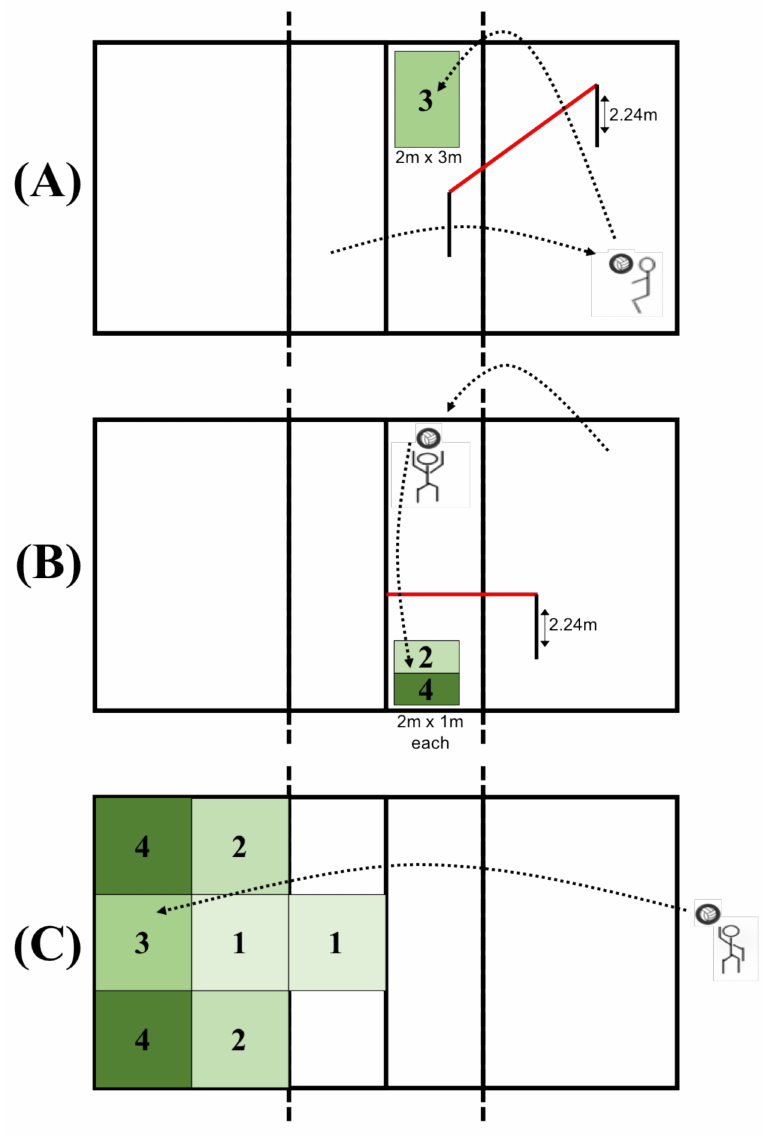
Figure 1. Test designs for the three volleyball techniques including scores. Each subtest corresponds to one technique: ( A ) underhand pass, ( B ) overhead pass, and ( C ) overhead